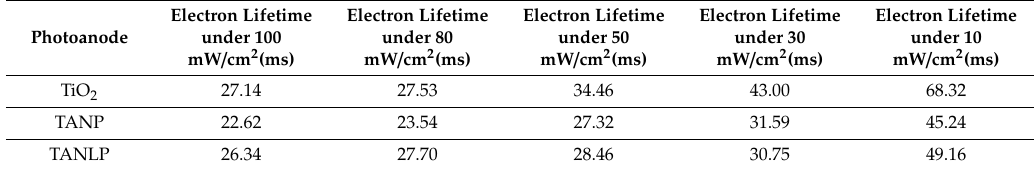
Table 5. The electron lifetime of the DSSCs with various photoanaodes under various illuminations.